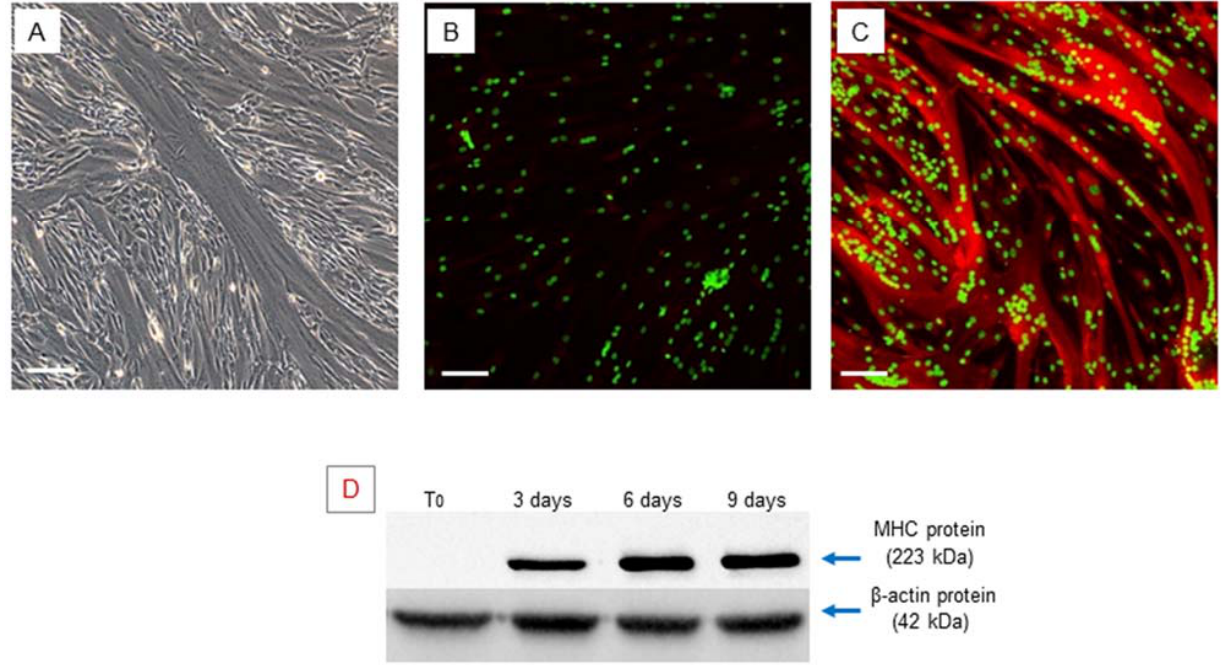
Figure 2. Myogenic differentiation: multinucleated cells (myotubes) observed after 9 days of myogenic induction, visualized by phase contrast microscopy, original magnification: 20×, scale bar 50 µm ( A ). Immunofluorescence staining of MHC in the obtained multinucleated cells. The obtained myotubes showed a high positivity of MHC protein, ( A ) negative control, myotubes stained with secondary antibody only, ( B ) myotubes stained with anti-MHC antibody, LSCM: red for MHC and green for nuclei, original magnification: 10×, scale bar 200 µm. ( B , C ). Western blot analysis of MHC during myogenic differentiation. The analysis showed an increase in the MHC gene during myogenic differentiation. Experiment was carried out in triplicate and is representative of the three established hSC lines ( D ).